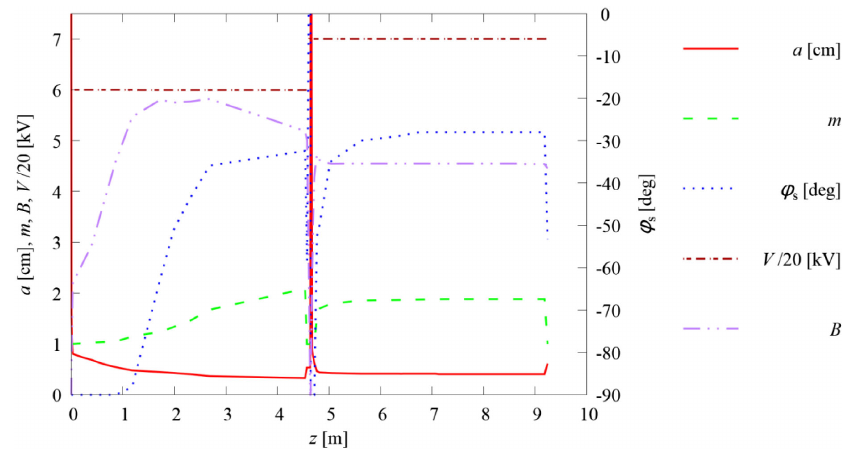
FIG. 2. Main design parameters of the “ 2-RFQ with drift ”